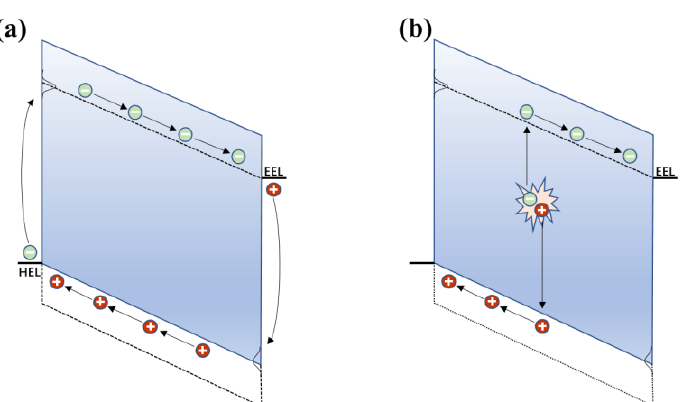
Figure 1. Dark current mechanisms: ( a ) charge injection from the contacts into the corresponding energy level and ( b ) bulk thermal generation of charge carriers within the active layer. (Reproduced with permission from [26]. Royal Society of Chemistry Publishing, 2020).